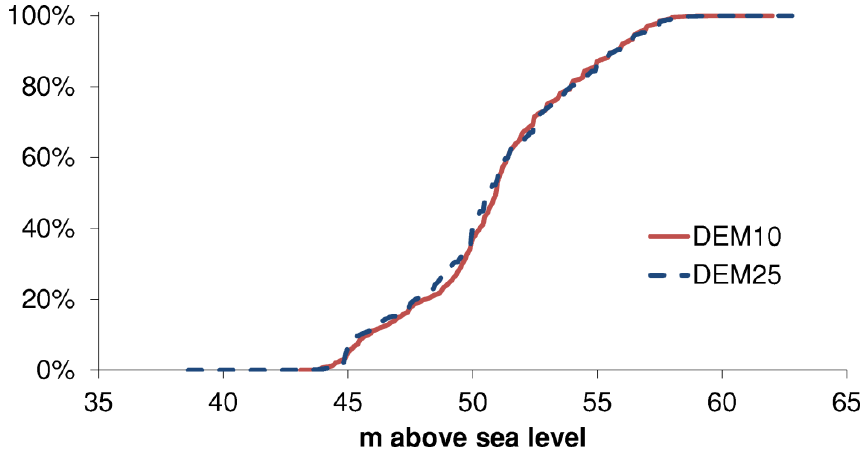
Figure 4. Cumulative curve of the elevation levels of the digital elevation models (DEMs) DEM10 and DEM25 used for the study site. Table 1. Combination and reduction of input data for sensitivity analyses.